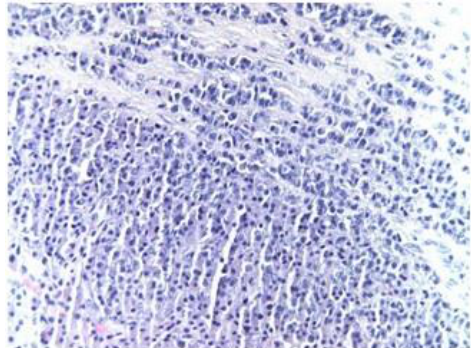
Figure 2. Olfactory neuroblastoma (HE stain, 40×) showing a solid and trabecular growth pattern composed of round, small cells that are relatively uniform with scanty cytoplasm and scattered chromatin pattern.